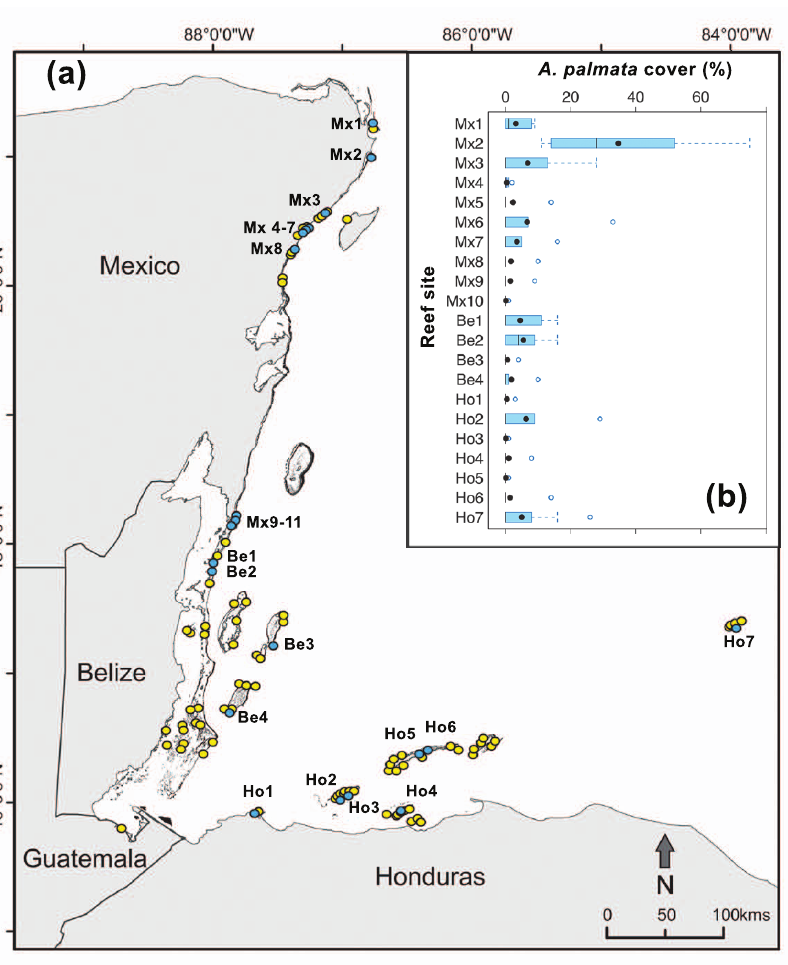
Figure 1. Distribution and abundance of Acroporapalmata in the Mesoamerican Reef System. ( a ) Location of the 107 coral reef sites sampled between 2010 and 2012. Blue circles represent sites in which Acropora palmata was recorded in the transects. Yellow circles represent sites where A. palmata was not recorded. ( b ) Box-and-whisker plot of percent A. palmata cover at the 21 sites where this species was found along the Mesoamerican Reef System in 2010–2012. The bottom and top of the box are the first and third quartiles, respectively, the black dot inside the box is the average and the black line is the median. Whiskers are the lowest datum still within 1.5 times that of the lower quartile and the highest datum still within 1.5 times that of the upper quartile. The open circles at the end of the boxplot represent outliers (transects with A. palmata cover values 1.5 times less or greater than the interquartile range). Sites are arranged from north to south for Mexico and Belize and from West to East for Honduras. For site codes see Table